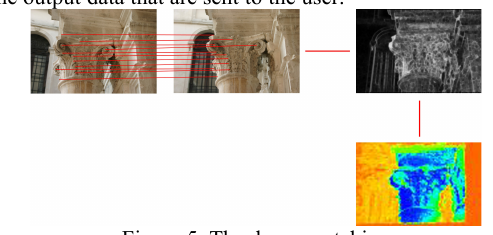
Figure 5. The dense